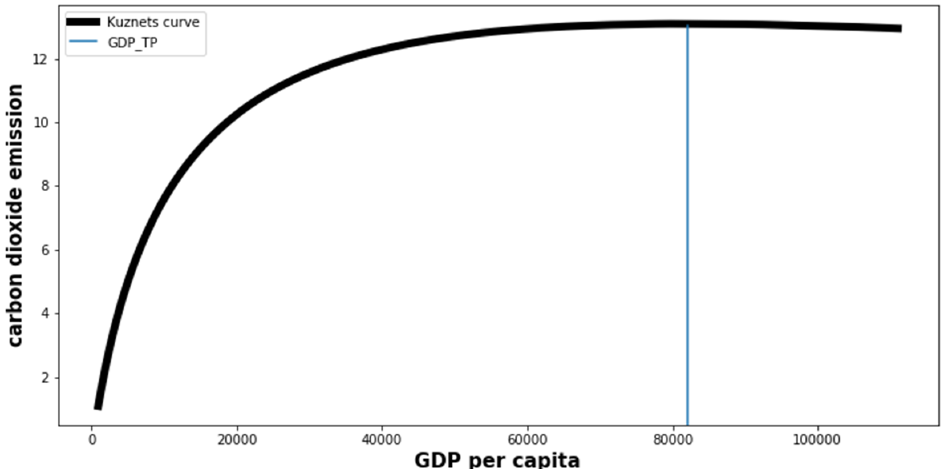
Figure 4. The shape of the Kuznets curve for the considered countries in the period of 2013–2019 (determined based on model (6)).